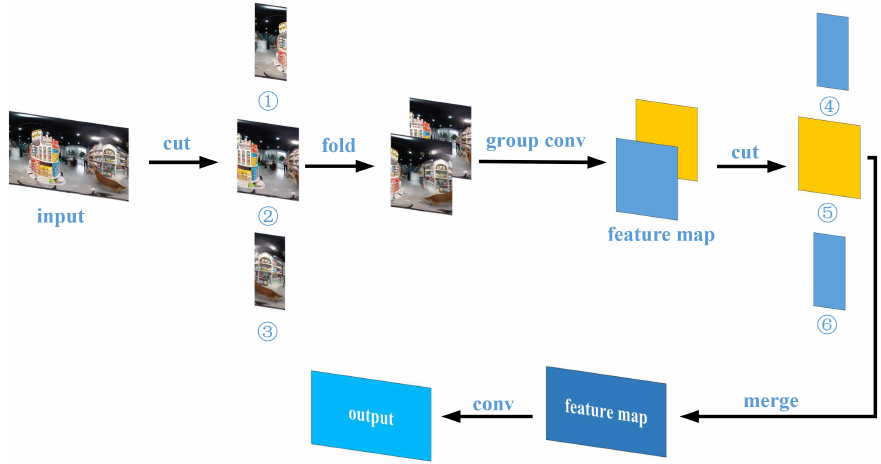
Figure 3. Detailed construction of